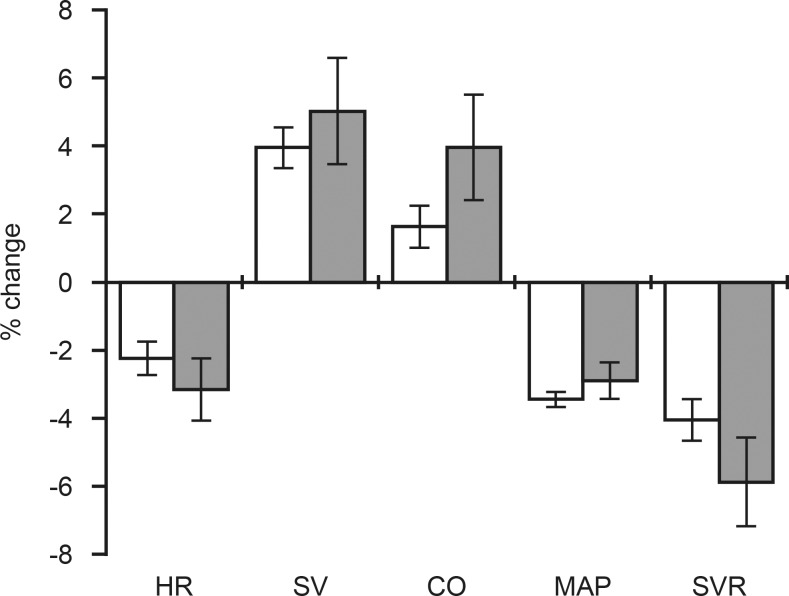
Differences in systemic maternal hemodynamics between pregnant women with normal and high (UtA PI).Data presented as mean ± standard error of mean (SEM). Maternal heart rate (HR), stroke volume (SV), cardiac output (CO), mean arterial pressure (MAP) and systemic vascular resistance (SVR). Percent change (∆%) representing the change from baseline to passive leg raising with normal (white bars) and high (grey bars) UtA PI.